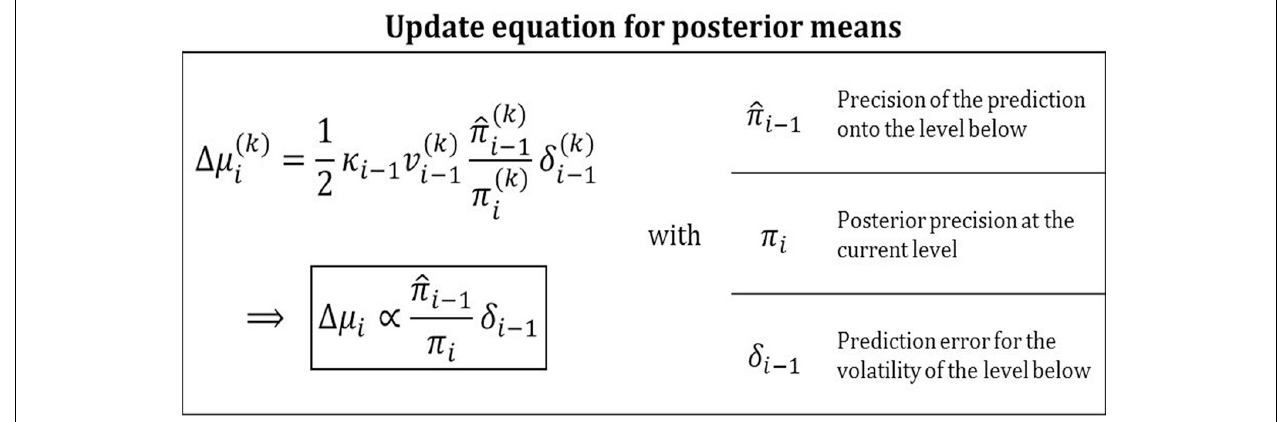
FIGURE 10 | Posterior mean update equation. Updates are precision-weighted prediction errors. This general feature of Bayesian updating is concretized by the HGF for volatility predictions in a hierarchical setting.